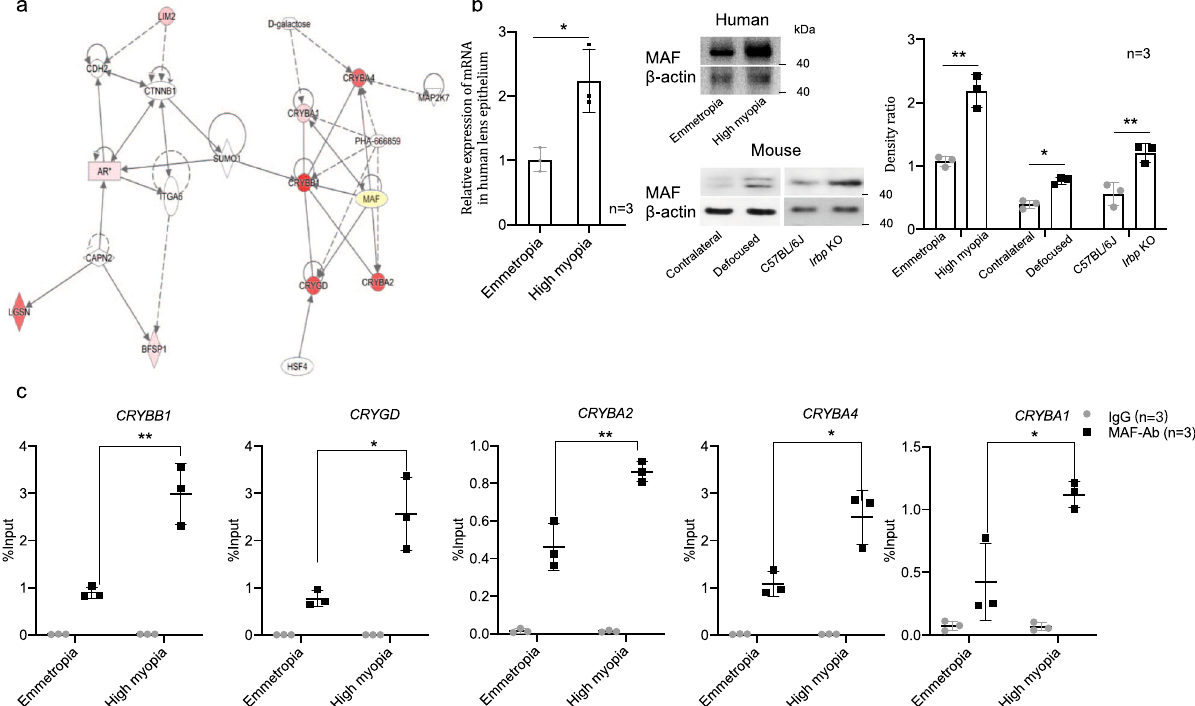
Fig. 4 Elevated MAF with higher recruitment to β / γ -crystallin gene promoters in high myopia. a The self-de fi ned network established by Ingenuity Pathway Analysis. b Examination of mRNA level of MAF in human lens epithelium by qPCR analyses ( n = 3, p = 0.015) and protein levels of MAF in lens epithelium of human and mouse highly myopic eyes by Western blotting ( n = 3, p = 0.002, p = 0.023, and p = 0.008, respectively). Right, the band density was normalized to loading control as a ratio for statistical analysis. c ChIP-qPCR analyses of the recruitment of MAF to CRYBB1 , CRYGD , CRYBA2 , CRYBA4 , and CRYBA1 promoters in lens epithelium from emmetropic and highly myopic patients ( n = 3, p = 0.005, p = 0.018, p = 0.007, p = 0.018, and p = 0.020, respectively). IgG was used as a negative control and the data presented were mean values relative to input (input%). n = biological replicates. In ( b and c ), pooled samples were used. Results are expressed as mean ± SD. Level of signi fi cance was detected by two-sided Student ’ s t test (emmetropia vs. high myopia and C57BL/6J vs. Irbp KO in ( b and c )) and two-sided paired t test (contralateral vs. defocused in ( b )). ** p < 0.01, and * p < 0.05. Source data are provided as a Source Data fi